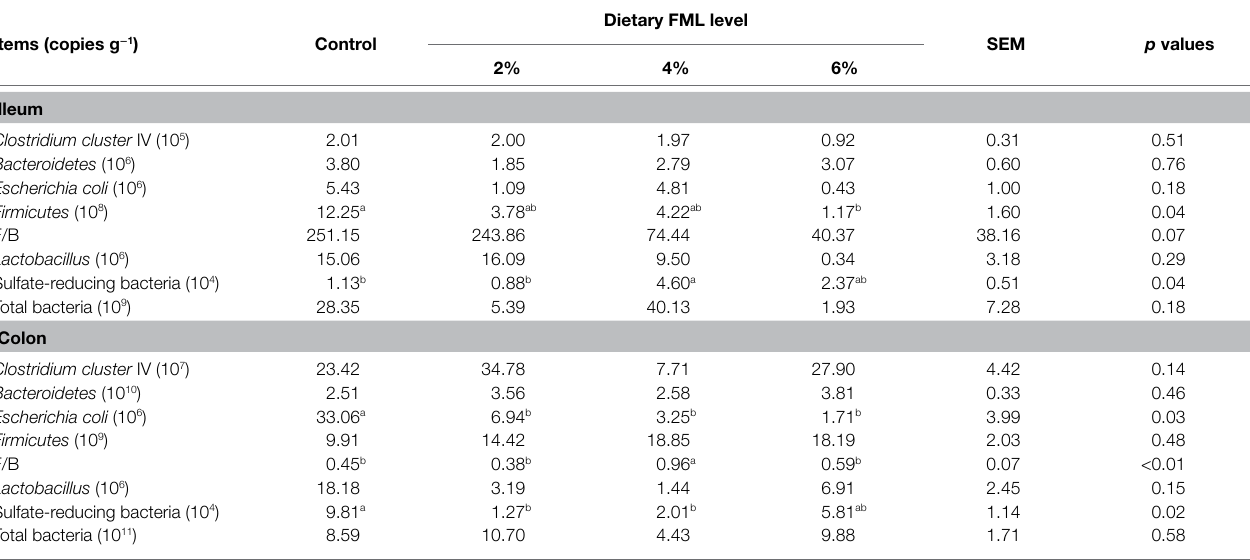
TABLE 4 | Effects of dietary supplementation with Fermented Mao-tai Lees (FML) on microbiota abundance in ileal and colonic contents of weaned